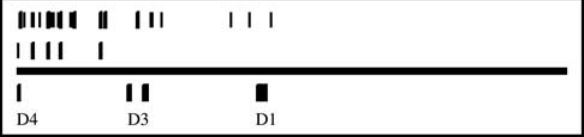
Figure 4 - Sequence conservation in HoxD cluster. Thick horizontal line indicates the range which has been analyzed, with position of HoxD genes indicated below it (all Hox genes have two exons). The bars right above the line indicate the positions of larger (50-400 bp) environments con- served at, or below, 0.1 average parsimony level, and the bars above them indicate the positions of shorter (25-100 bp) regions at the same level of conservation.